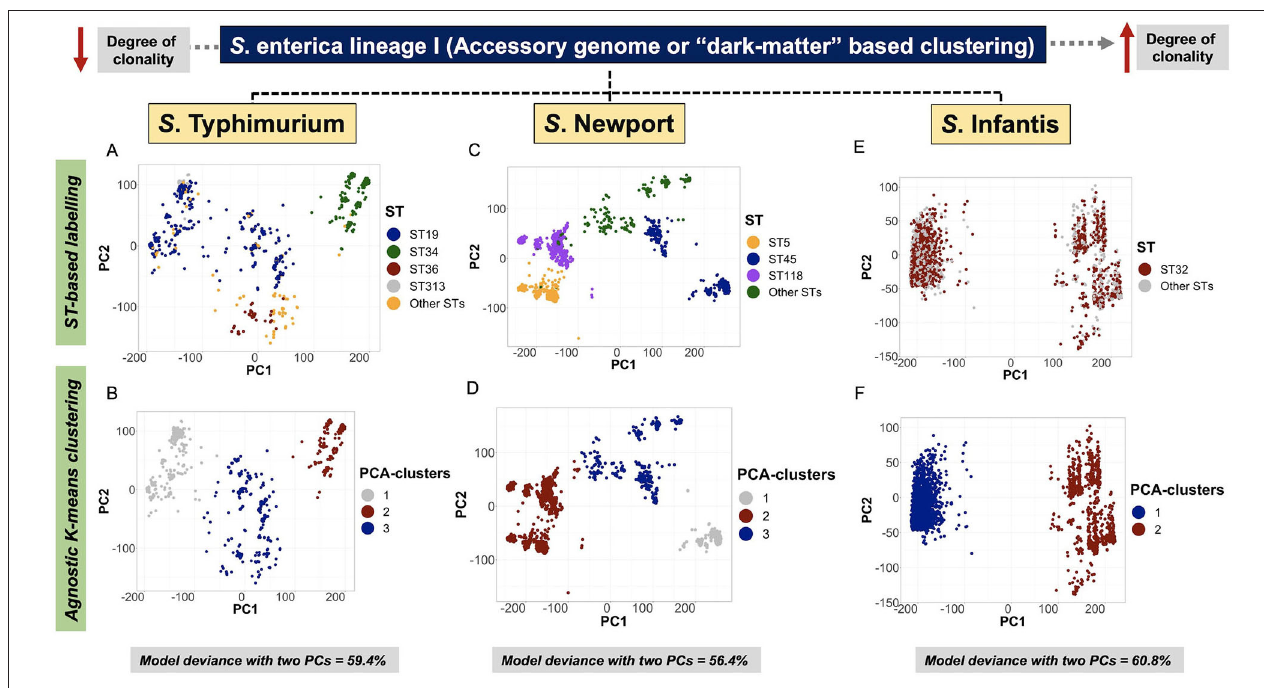
FIGURE 4 | Accessory genome-based clustering revealed a co-inherited pattern with genomic backbone, and unique cryptic clusters across serovars. A logistic PCA was used to ordinate genomes in two dimensions (PC1 and PC2) by only using “shell-genes or shell-loci” (i.e., genes that are present in ≥ 15% and < 95% of genomes in the data) as input. The “shell-loci” data are comprised of binary information containing 1 for presence and 0 for absence of each locus. For S . Typhimurium, only data generated for subset 1 ( n = 1,076 genomes) out of the 20 random subsets is presented here. (A) ST-based labeling of the PCA ordination showing all four major STs, including ST34 (Monophasic) as a discrete cluster (green color). (B) Agnostic k-means clustering using the two PCs as input, generated three clusters for the S . Typhimurium data, of which cluster 2 overlapped with the ST34-Monophasic sub-population. For S . Newport ( n = 2,365 genomes), (C) ST-based labeling showed ST5 and ST118 as neighboring clusters, and a separation of the ST45 lineage with two cryptic sub-clusters within it. (D) Similar to S . Typhimurium, the S . Newport data were clustered into three clusters based on an agnostic analysis, for which cluster 1 overlaps with the topological distribution of ST5 and ST118, reinforcing their high degree of genetic relatedness (i.e., recently shared a common ancestor). As for S . Infantis ( n = 2,851 genomes), (E) ST32 is spread across the two cryptic clusters present in this population; whereas, non-supervised clustering of the S . Infantis data revealed two cryptic clusters within it (F) . Across all serovars, the optimal number of k-means clusters was determined by examining the within cluster sum of squares across the number of clusters tested by the algorithm. All model deviances were calculated using only the first two PCs.